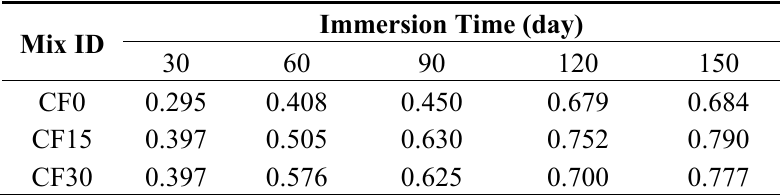
Table 1. Contents of chloride ion in the surface layer of concrete at different immersion time